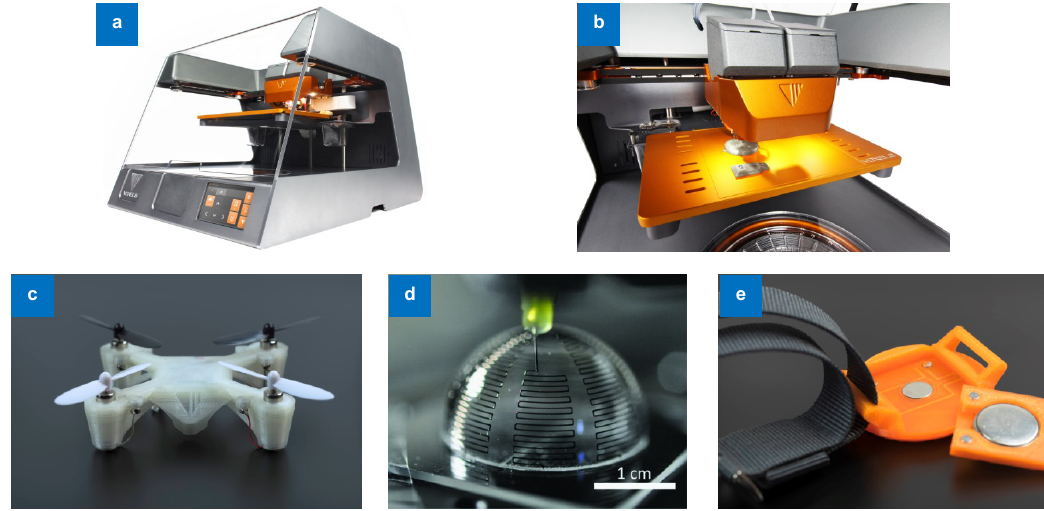
Fig. 13 | Voxel8 and some printed products 32 . ( a , b ) Photograph of Voxel8 3D printer. ( c ) Printed unmanned aerial vehicle. ( d ) Printed antenna (dome). ( e ) Printed wearable